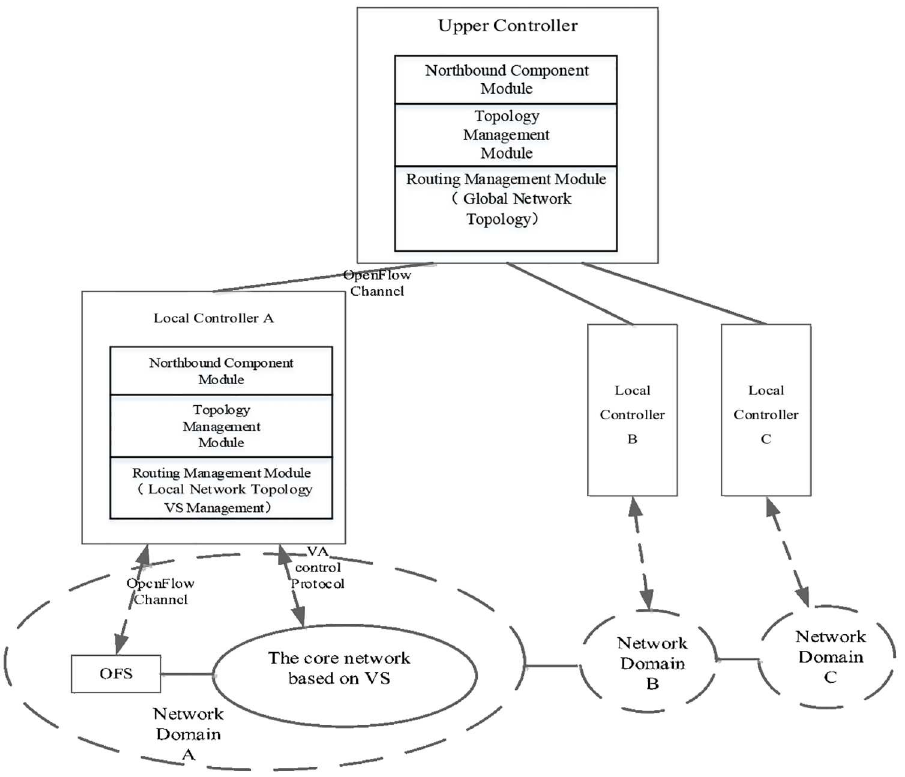
Fig 6. The control plane of the SCDCN model. The VS has simplifiedthe model and only needsto cooperate to completea few signal processingoperation.